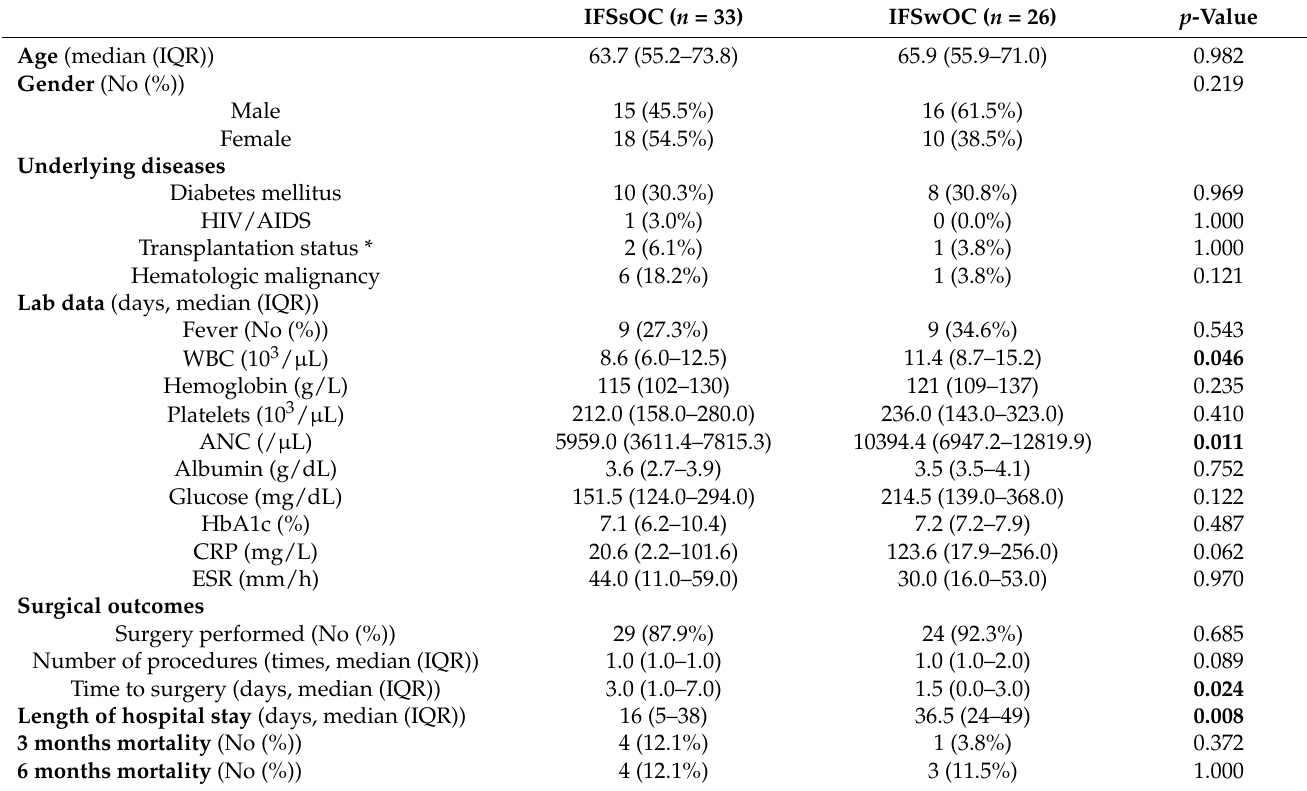
Table 3. Demographic data, laboratory results, surgical outcomes, morbidity, and mortality between the IFSsOC and IFSwOC groups.